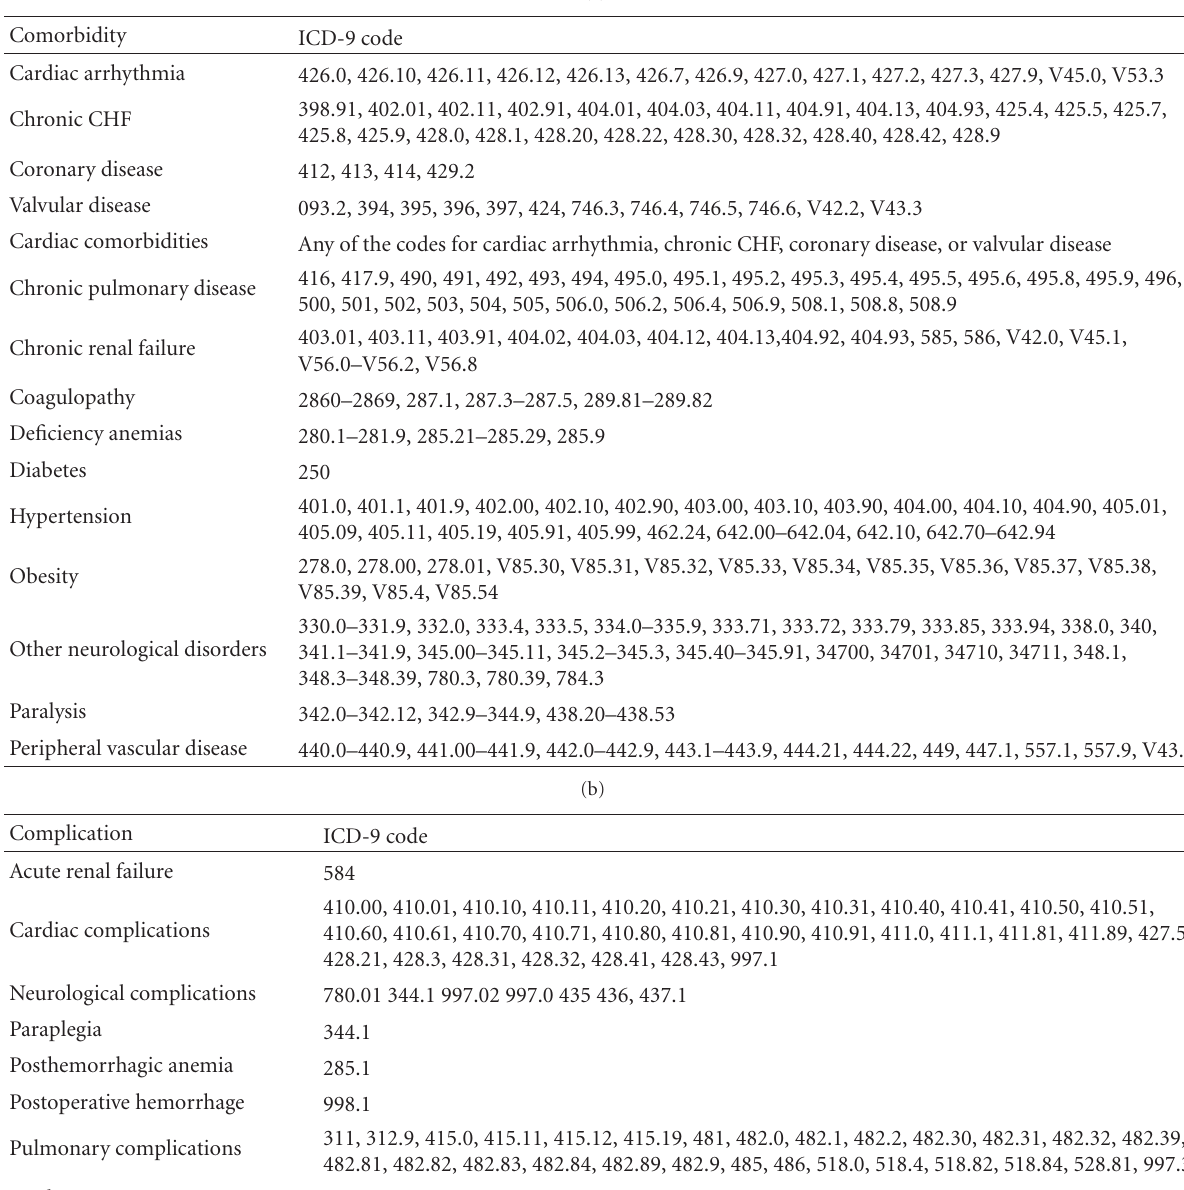
Table 1: List of ICD-9 codes for comorbidities and